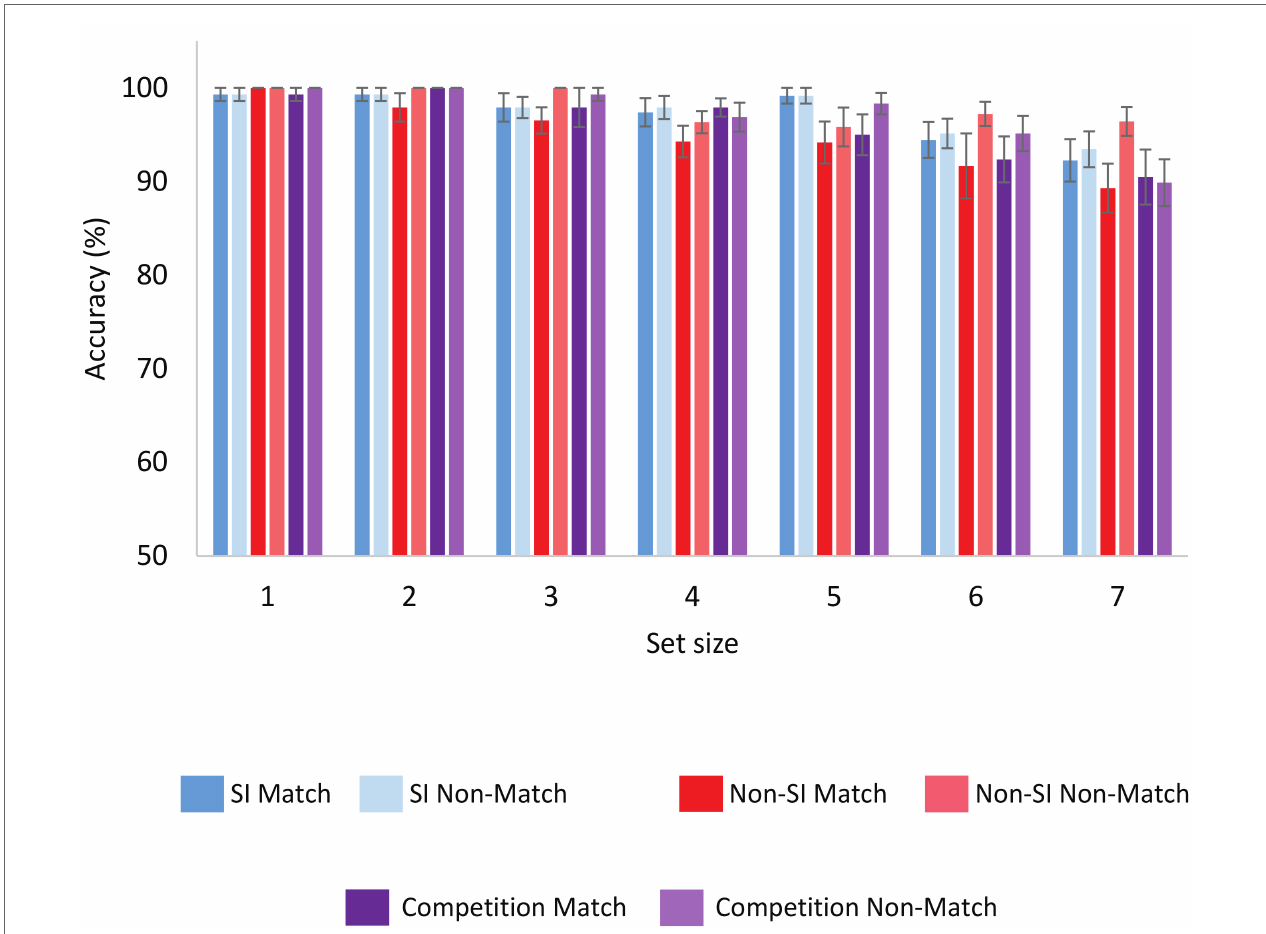
FIGURE 4 | Accuracy as a function of encoding condition, set size and probe condition (match or non-match) for Experiments 1 and 2. Error bars represent standard error of the mean. SI,